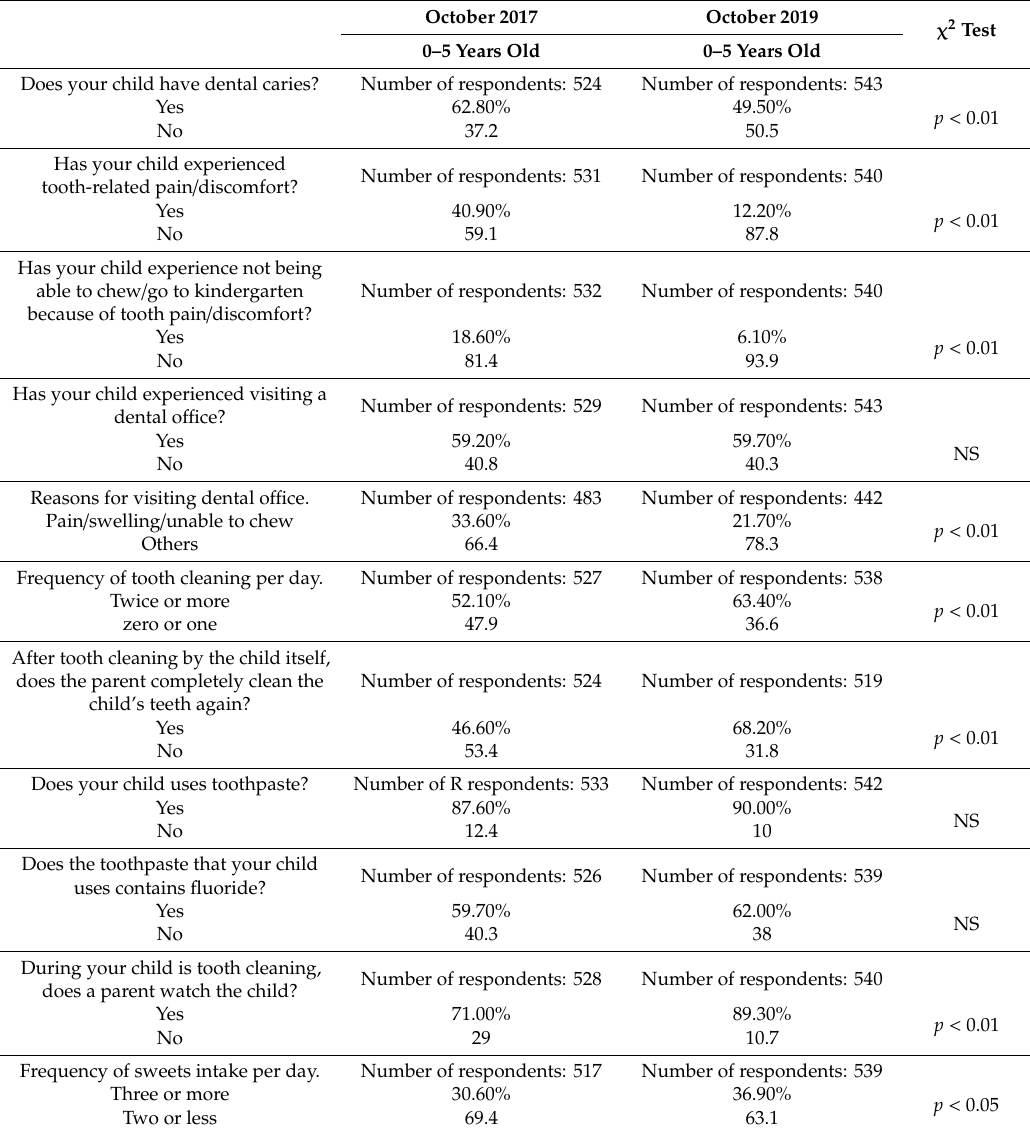
Table 2. Questionnaire